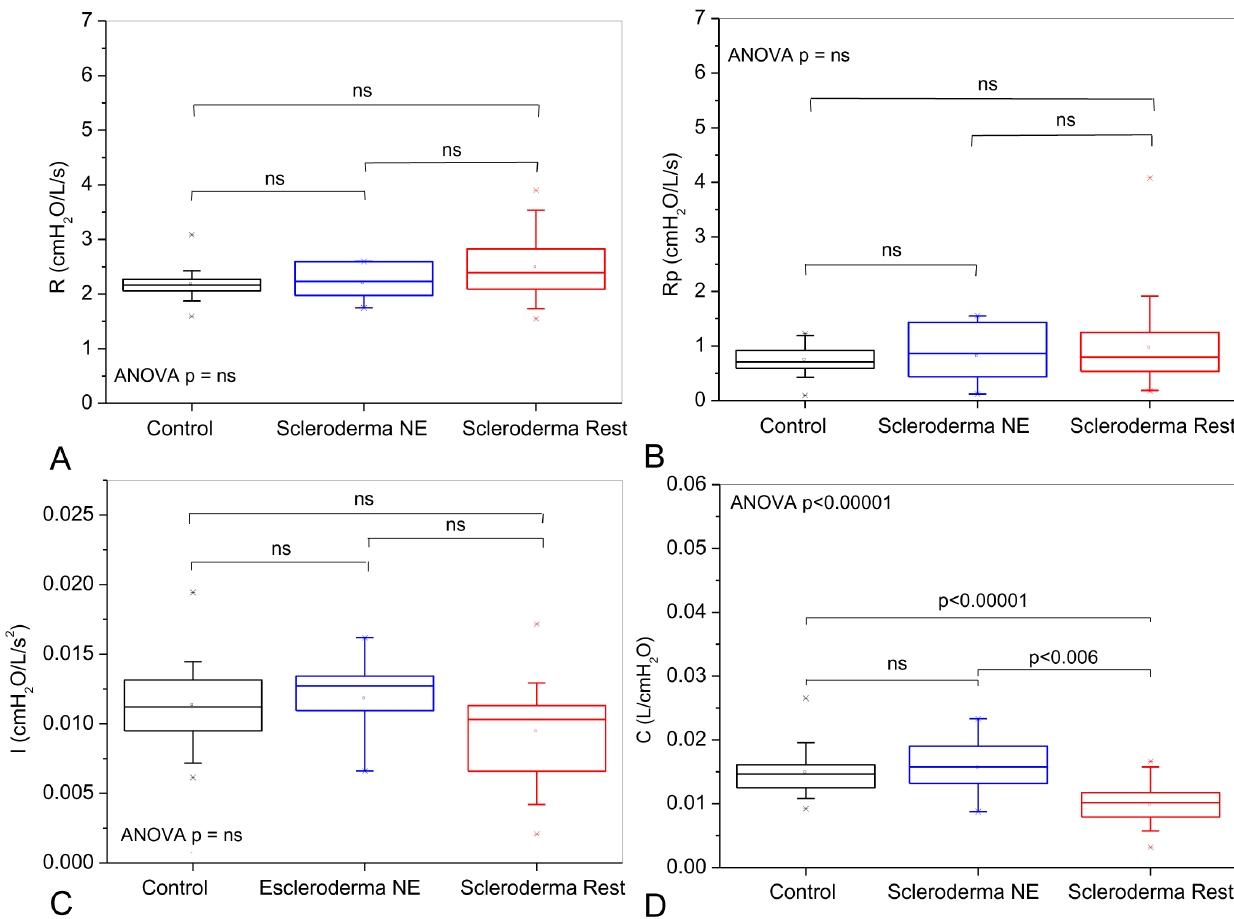
Figure 7. Influence of the restricted pattern in the lung volume tests on parameter values estimated from the model described in Figure 1. Changes in central (A) and peripheral resistance (B), as well as in I (C) values were non-significant. Compliance was significantly reduced in restrictive patients (D).